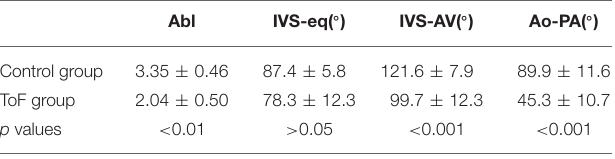
plugin (Kai Uwe Barthel, Internationale Medien informatik, HTW Berlin, Berlin, Germany http://rsb.info.nih.gov/ij/plugins/